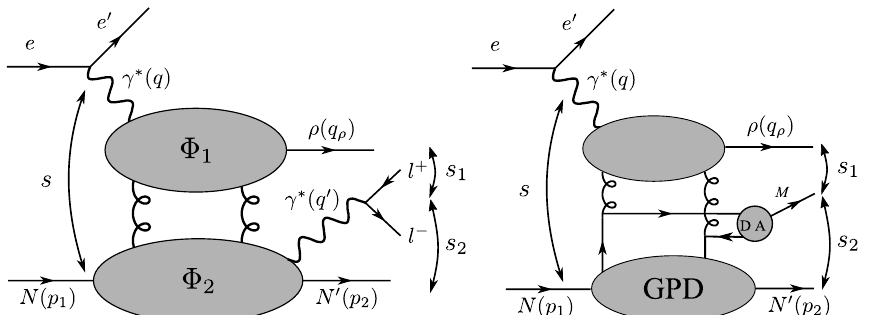
Figure 1: Left panel: the diffractive amplitude (here for the ρ + lepton pair) is written in the k -factorization approach as the convolution of two impact factors ( Φ T and the Pomeron propagator, which at lowest order is a two gluon exchange. Right panel : the impact factor Φ is then calculated (here for the ρ + meson case) in 2 collinear factorization, in terms of GPDs and